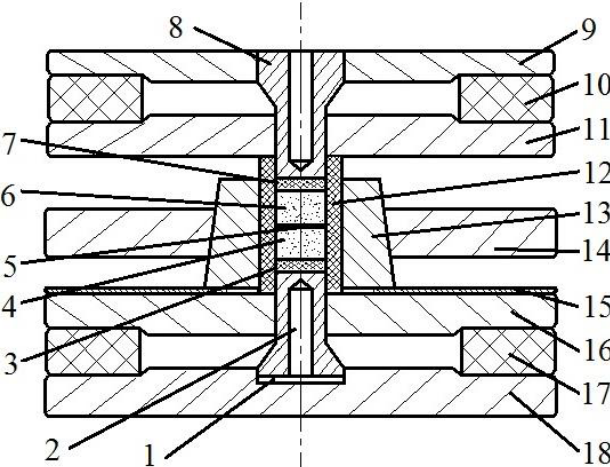
Figure 26. Technological assembly for sintering of diamond-containing composite